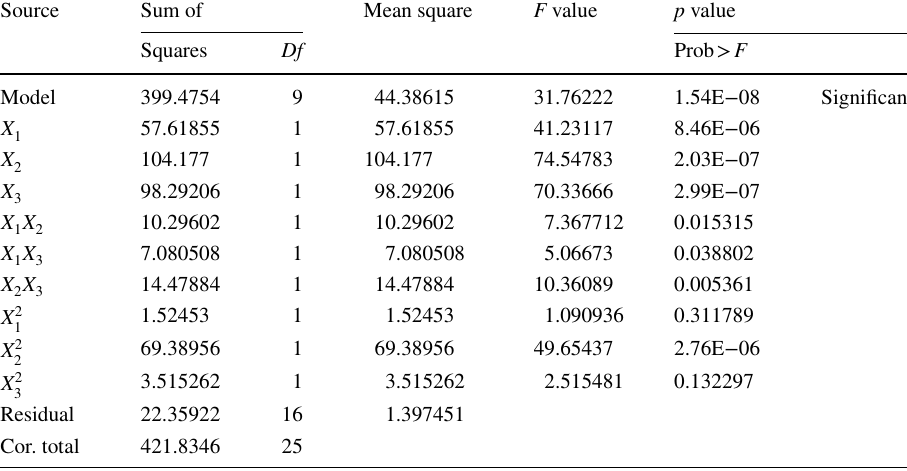
Table 3 ANOVA for response surface quadratic model for Pb(II) removal from an